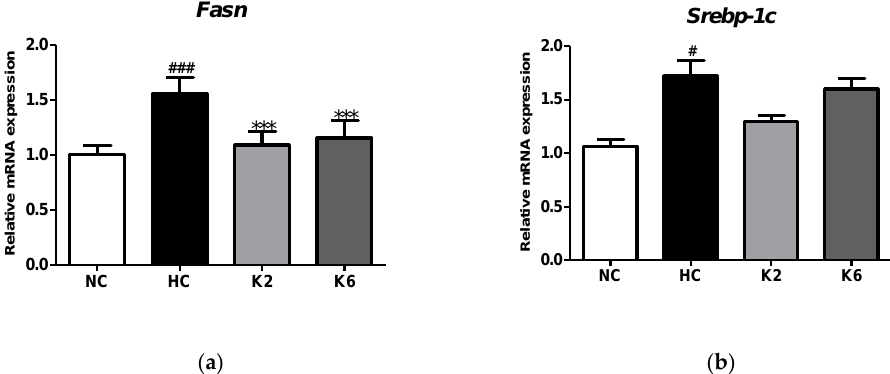
Figure 2. Effect of L. plantarum treatments on mRNA expression of lipogenesis-related genes in the HFHF diet rat. mRNA expression level of ( a ) Fasn and ( b ) Srebp-1c in the small intestine. Values represent the mean ± SEM. # p < 0.05 and ### p < 0.001 vs. control group (NC), *** p < 0.001 vs. HC group. NC, normal diet control; HC, HFHF diet control; K2, HFHF diet with K2; K6, HFHF diet with K6; Fasn , fatty acid synthase; Srebp-1c , sterol regulatory element-binding protein 1c.